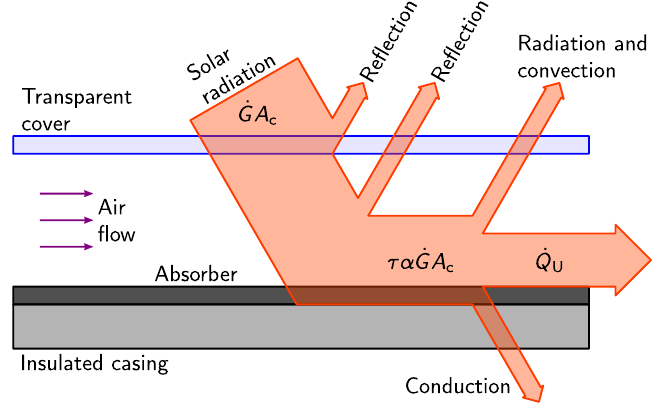
Figure 3. Energy fluxes in solar